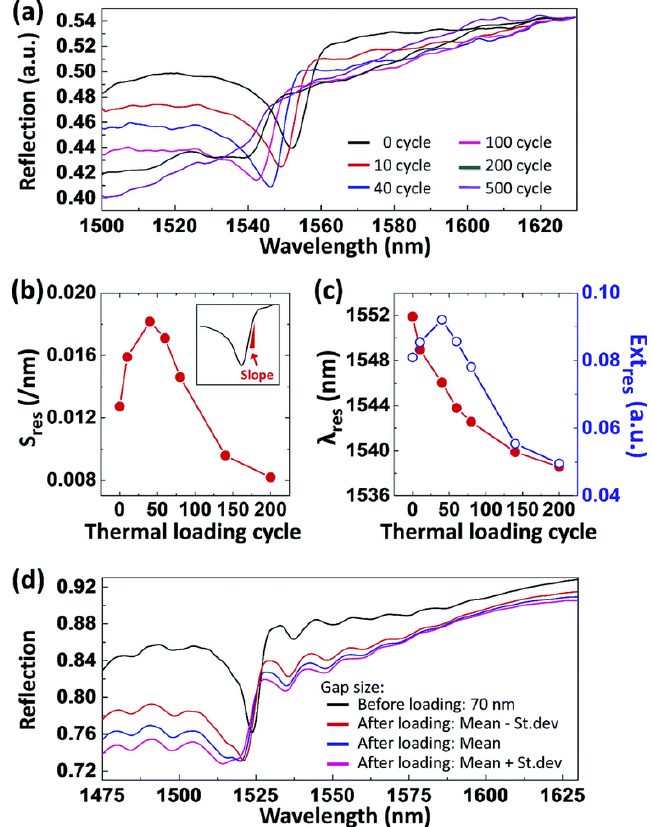
Figure 34. Optical characteristics of the on-fiber Au nanopatch array in experiments: ( a ) reflection spectra measured at room temperature before thermal loading; ( b ) measured S res ; ( c ) λ res , and E xtres as a function of thermal loading cycle; ( d ) Simulated reflection spectra before and after 500 thermal loading cycles. Reprinted with permission of [96].